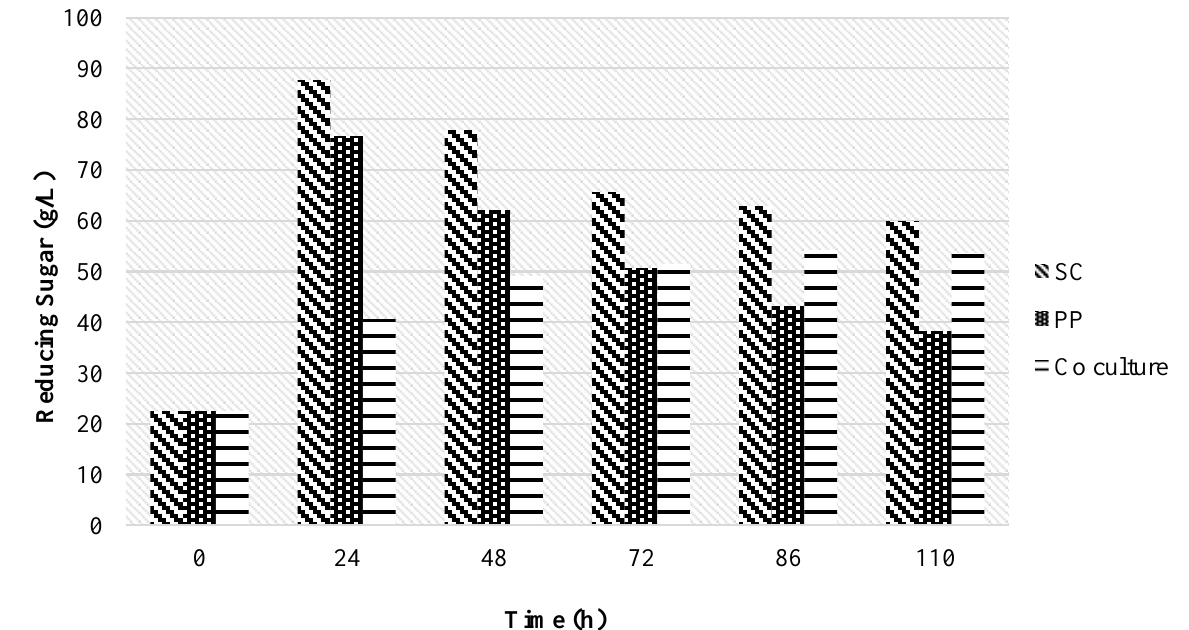
Figure 3. Reducing sugar for all yeast strains.